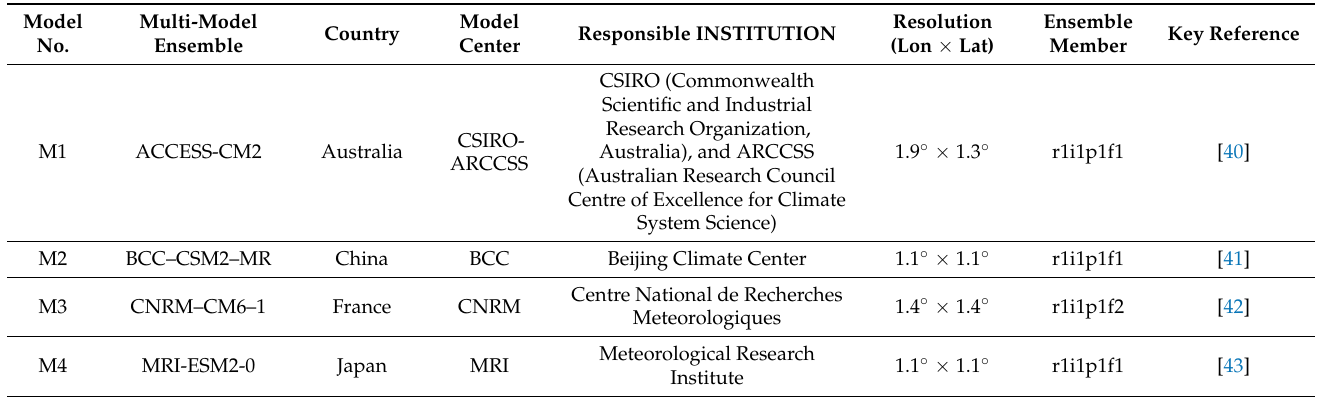
Table 1. Characteristics of the four CMIP6 climate models utilized in the study.